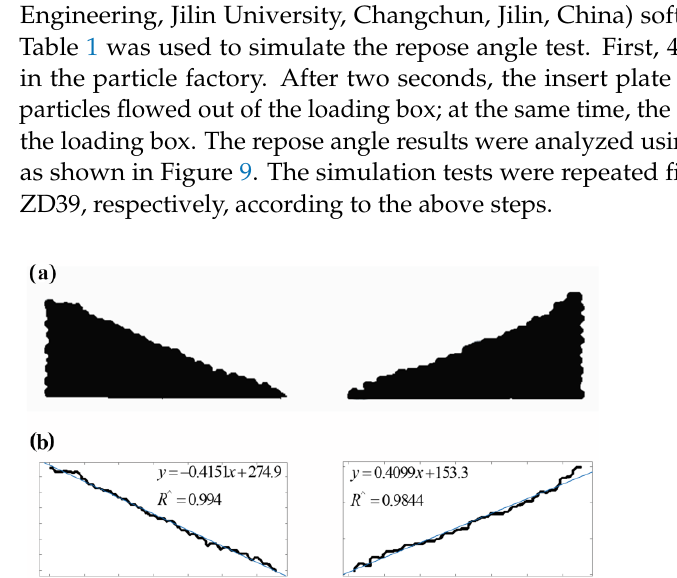
Figure 9. Image of (a) repose angle simulation results and (b) processing diagram.